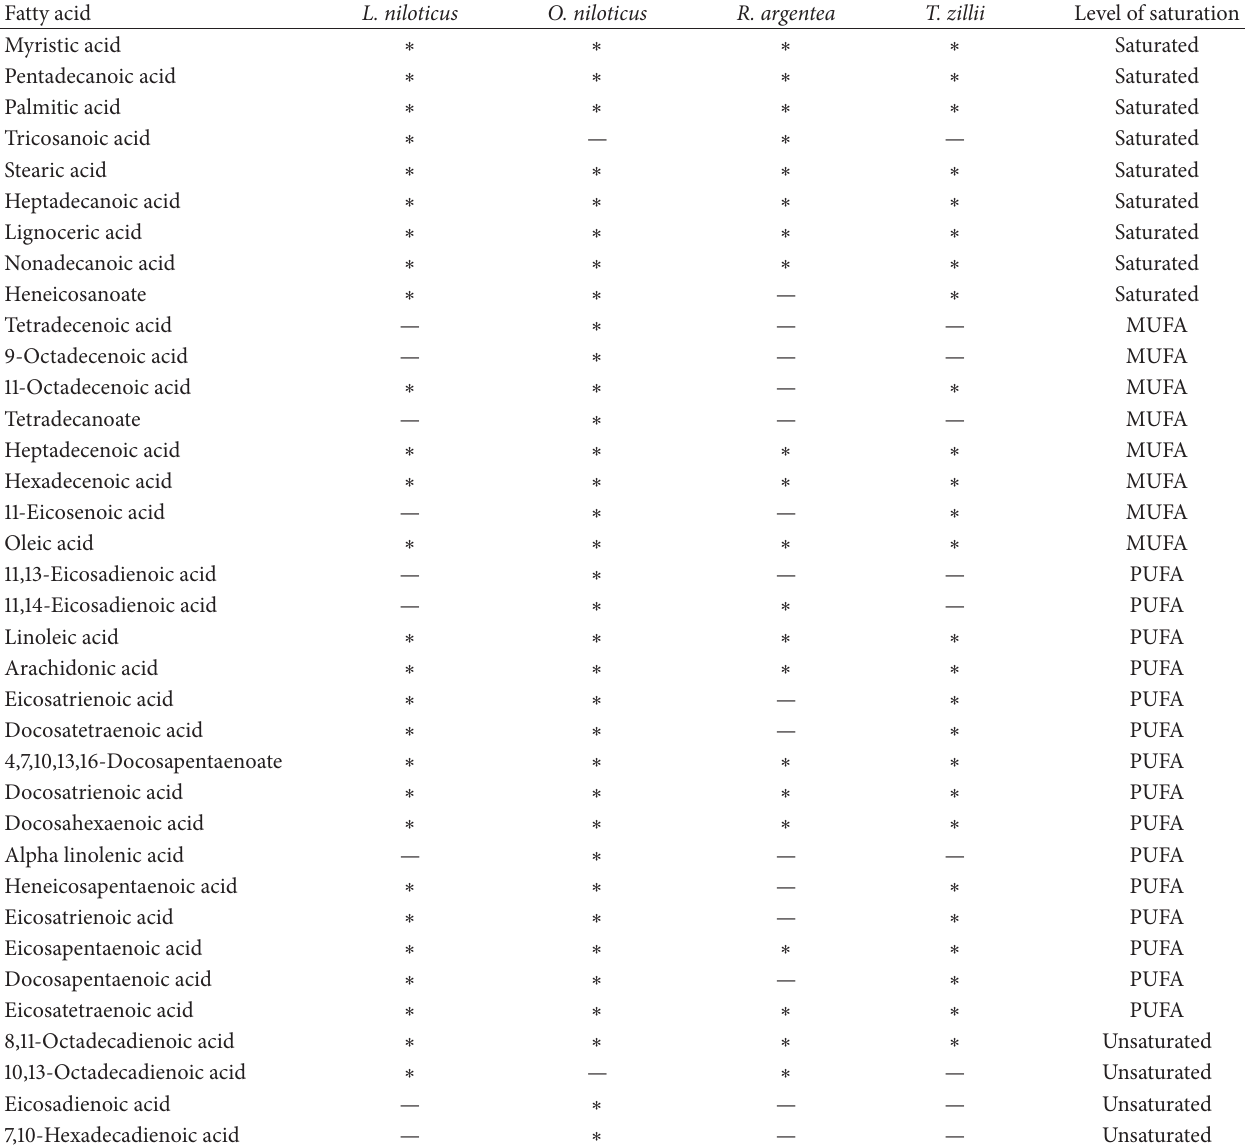
Table 1: Fatty acid composition from the four commercial fish species of Mwanza Gulf in Lake Victoria. Fatty